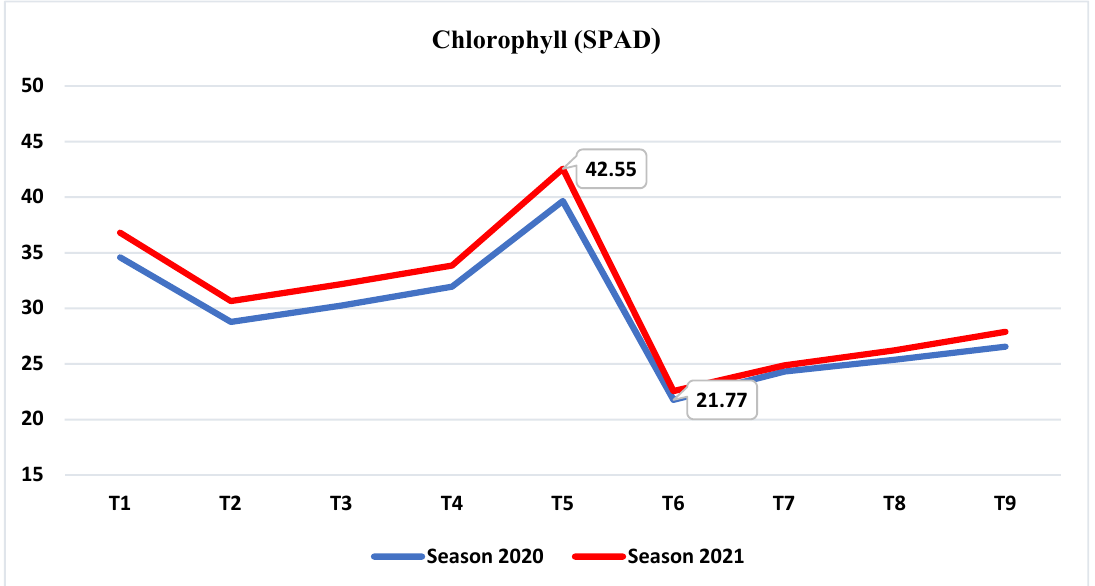
Figure 4. E ff ect of mineral fertilizer alone or combined with SAPs on total chlorophyll (SPAD) in leaves of Autumn Royal grapevines in 2020 and 2021 seasons.